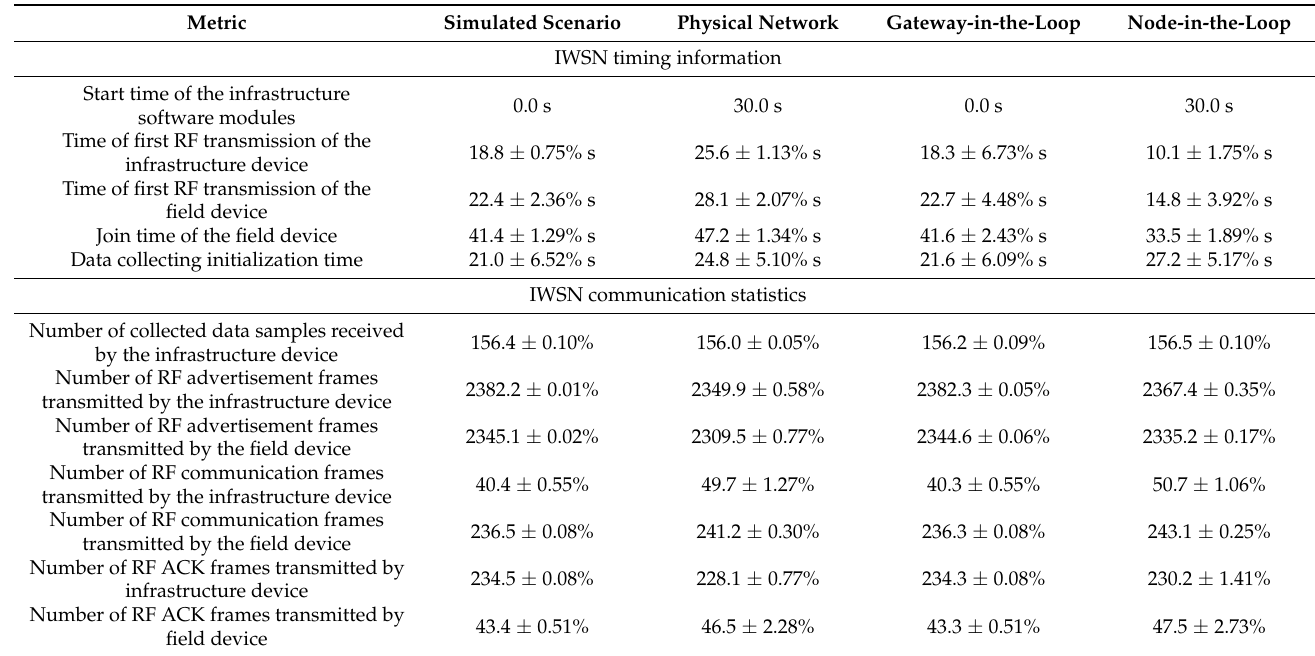
Table 4. The confidence intervals of the evaluated